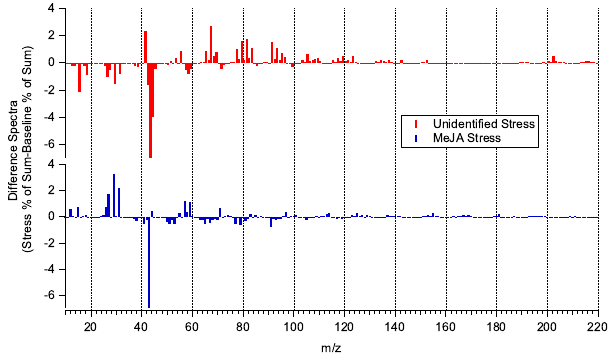
Figure 8. Stress response spectra comparing the effects of two dif- ferent types of stress – an unidentified stress (red) and a MeJA treat- ment (blue). The x axis shows the m/z values and the y axis denotes the difference between the normalized stress spectrum and the nor- malized baseline